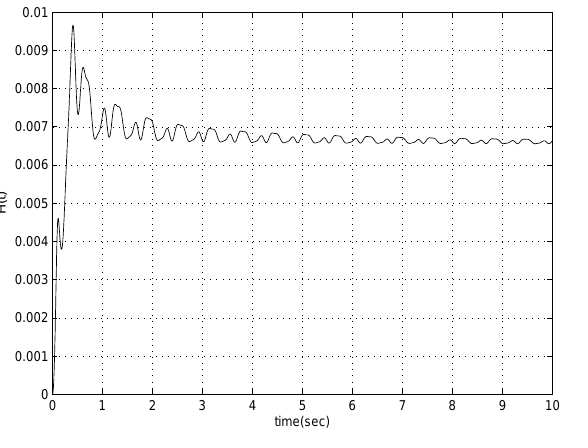
Fig. 4. Responses of the estimation error e ( t